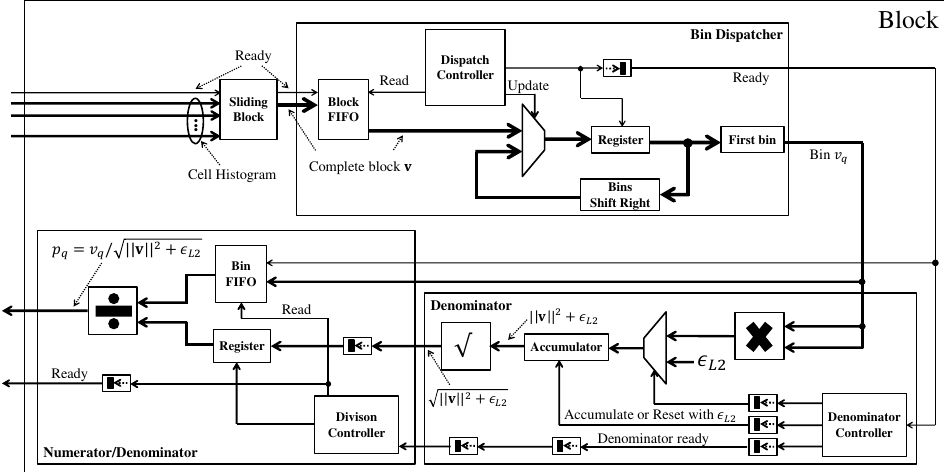
Figure 8. The block normalization